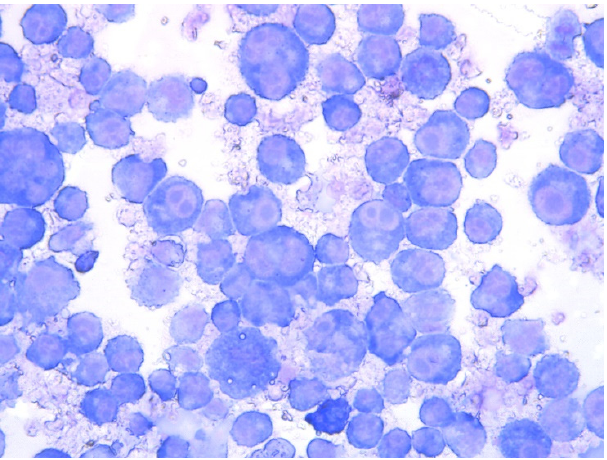
Figure 4. Celular culture with the presence of T. ovis schizonts in lymphocytes. Obj. 40×. Biological material courtesy Morocco’s Pasteur Institute, Morocco.